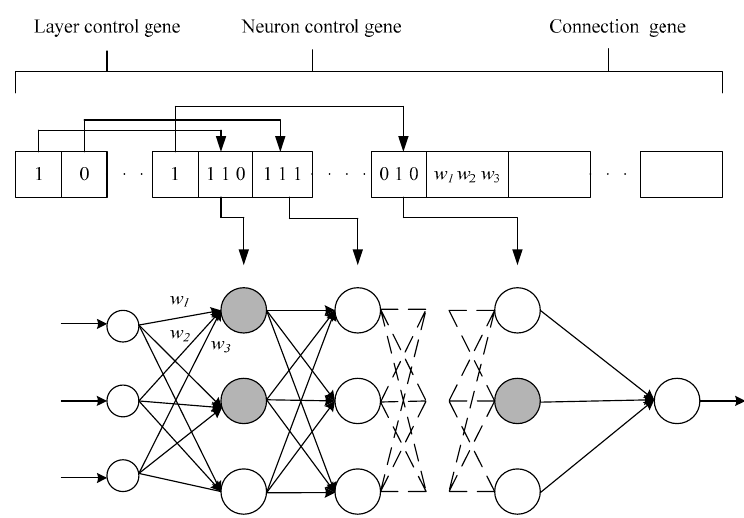
Figure 5. Structure of a hierarchical neural network.